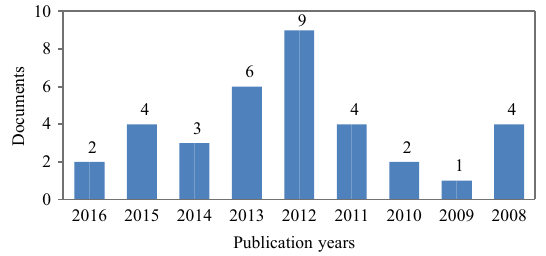
Fig. 2. Published papers using COPRAS-G method over